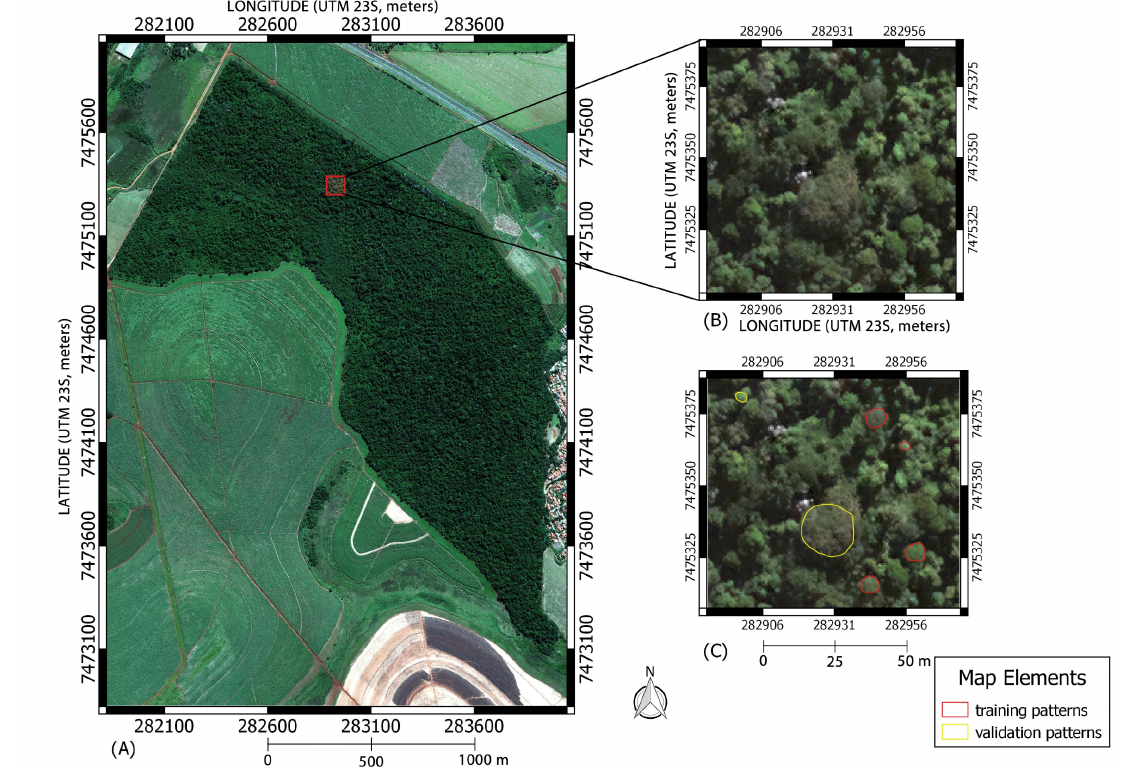
Figure 3. ( A ) The Santa Genebra Reserve. Both ( B , C ) Exhibit the same small region from the Santa Genebra Reserve; in ( C ), the red polygons belong to the training set and yellow polygons belong to the validation set.